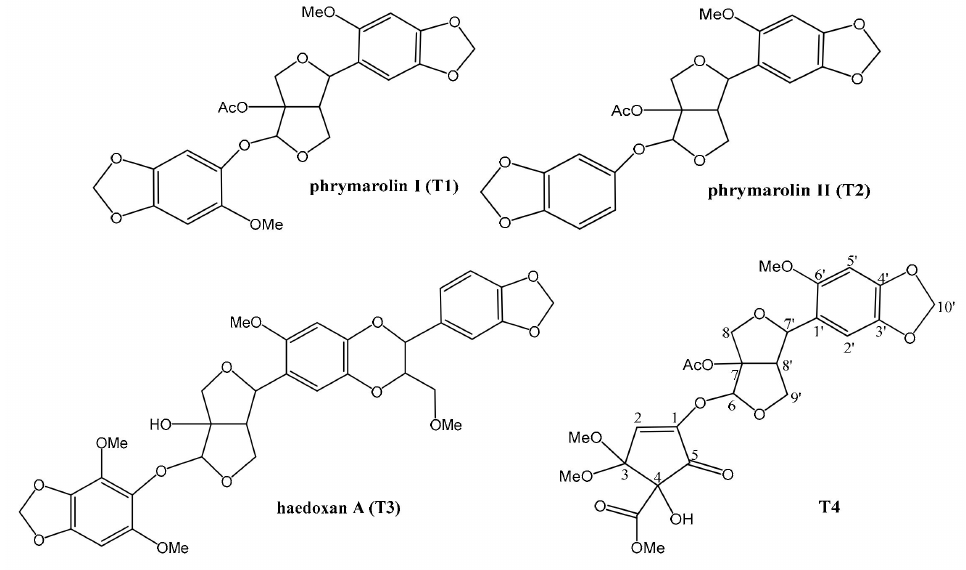
Figure 1. Lignans isolated from P.